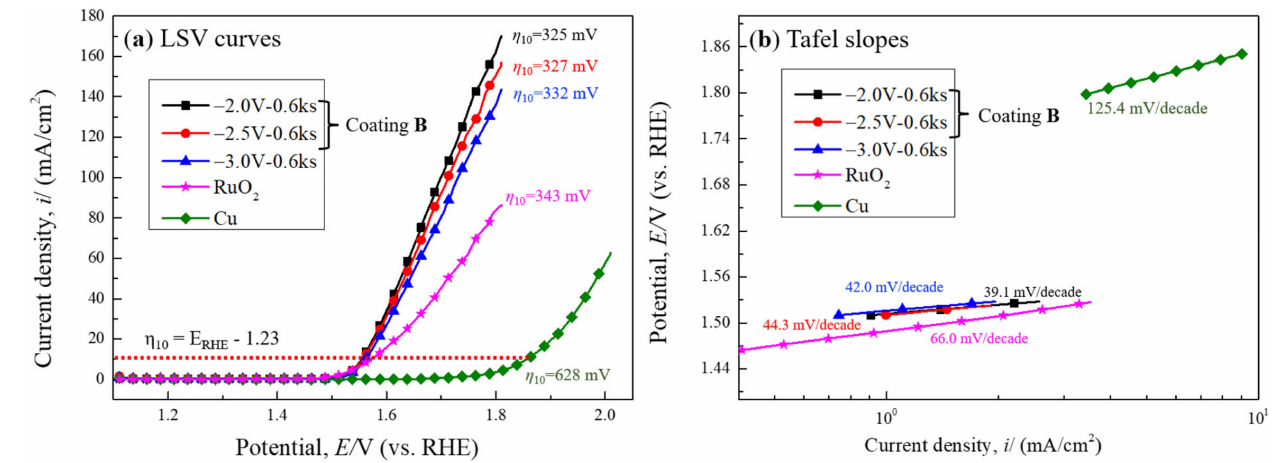
Figure 12. Polarization LSV curves ( a ) and Tafel slopes ( b ) of Cu, RuO 2 , and coating B deposited at − 2.0 V, − 2.5 V, and − 3.0 V (vs. SSE) for 0.6